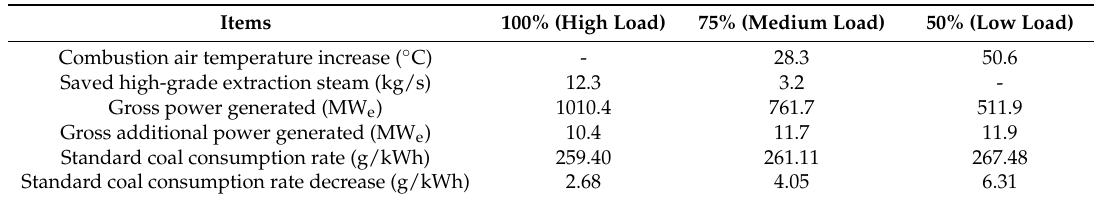
Table 8. Thermal performance of the proposed SAPG.